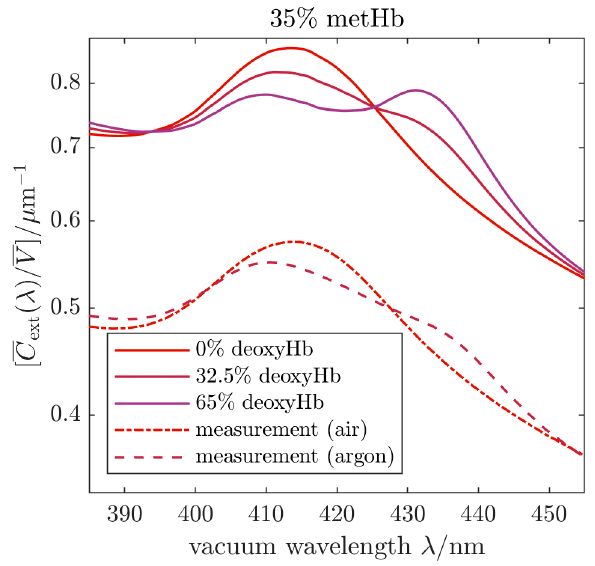
Figure 3. Volume-specific spectral extinction cross sections measured (dash-dotted and dashed lines) in air and using argon for deoxygenation. Calculated, volume-specific spectral extinction cross sections (solid lines) are included to illustrate the change of oxygenation of the HbMPs.